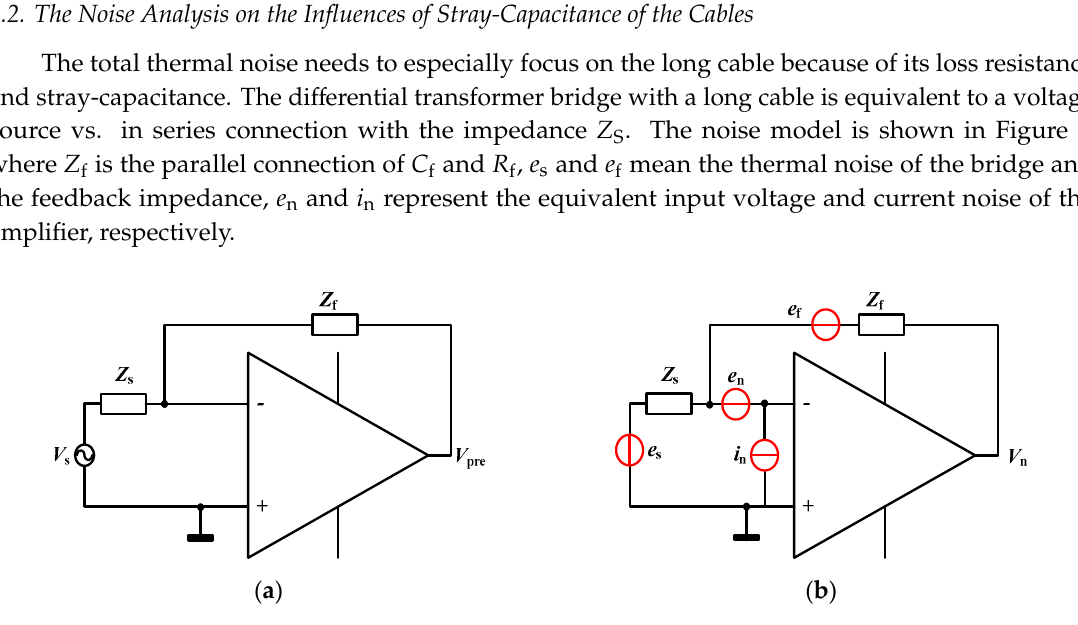
Figure 3. The equivalent function ( a ) and noise ( b ) model of the front-end circuit.